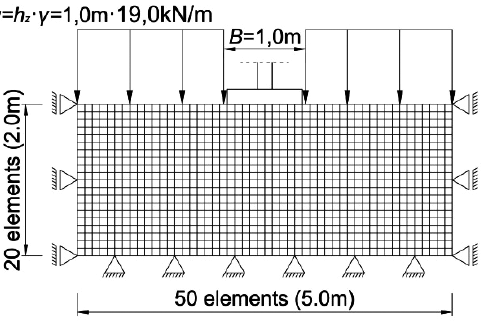
Fig. 8. Design values of the bearing capacity depending on the footing width B and reliability index β